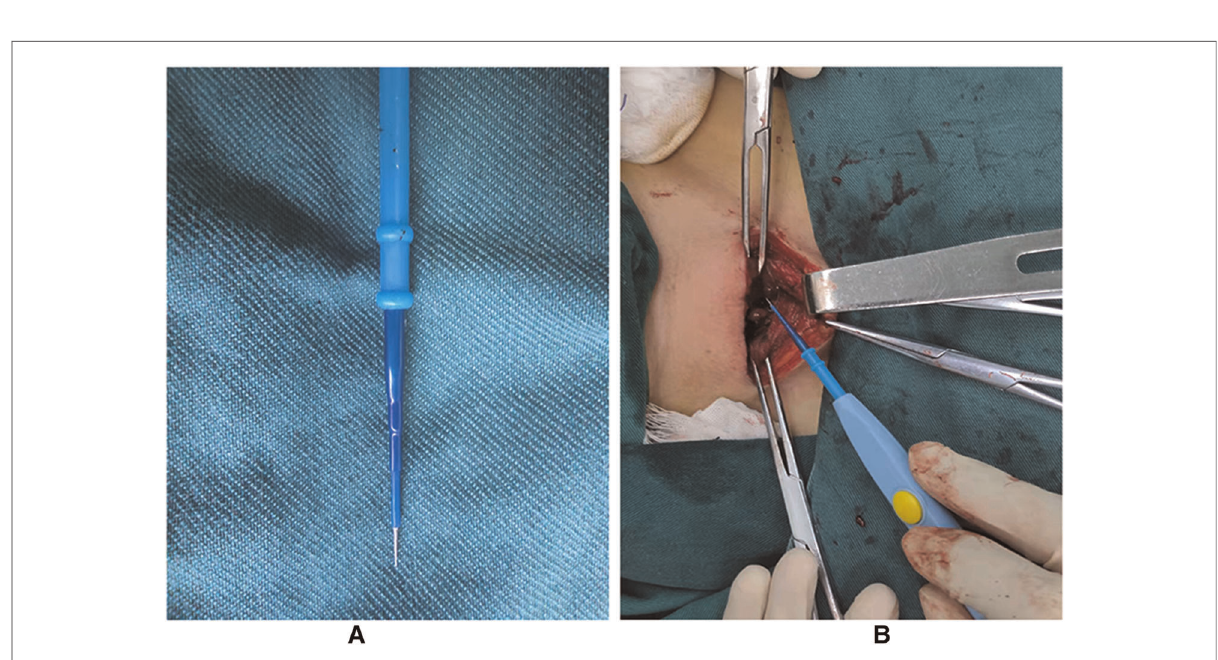
FIGURE 4 The application of MDTN in thyroidectomy. ( A ) The sharp tungsten tip of MDTN; ( B ) The operative view of thyroidectomy utilizing MDTN.